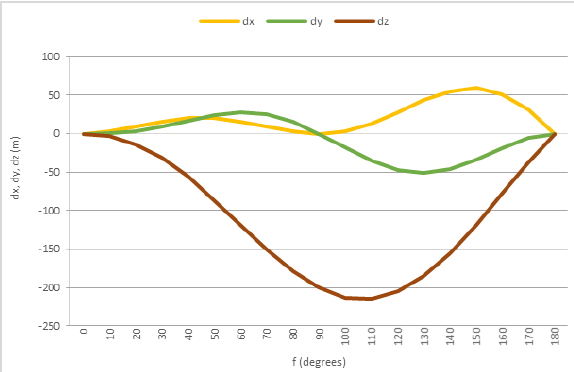
Figure 2. Coordinate change by applying rotation to all three axes (rotation through x–y–z).